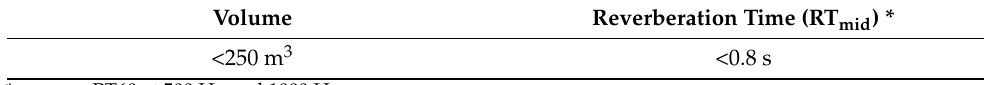
Table 14. Proposed RT mid standard for Korean learning spaces for elderly people (unoccupied).